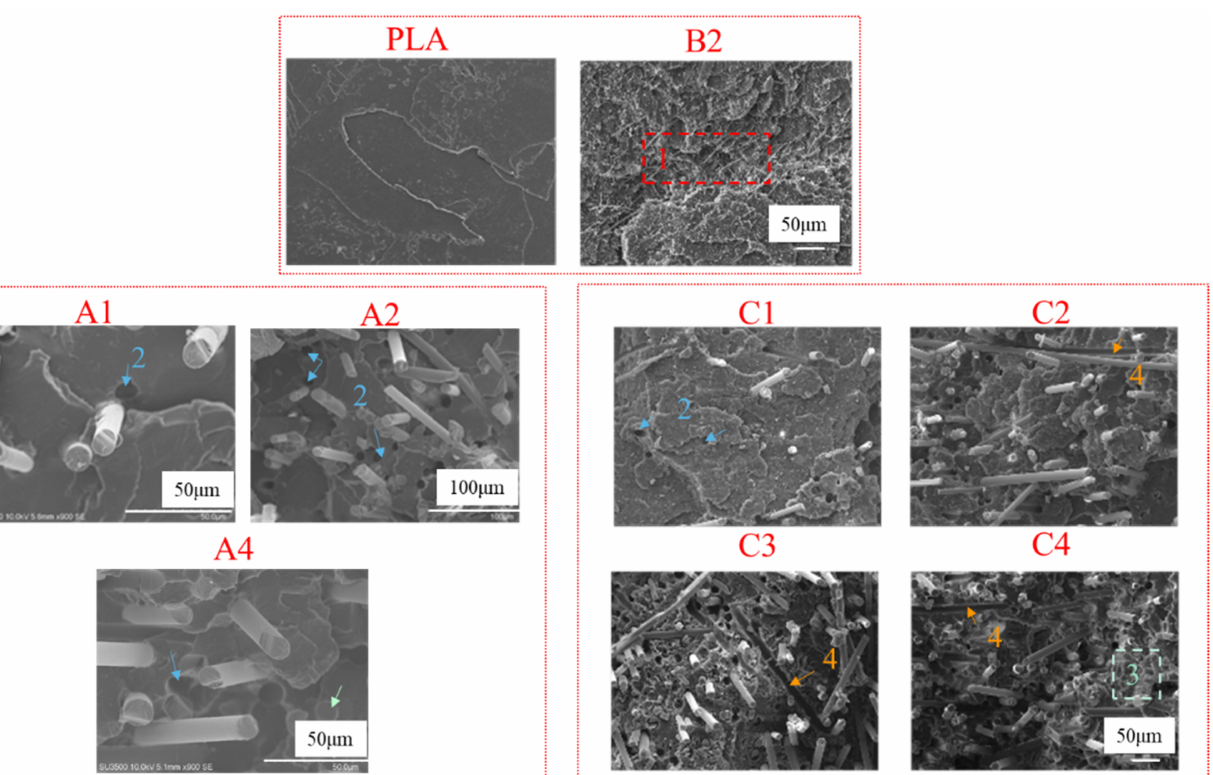
Figure 8. The tensile fracture morphology of PLA, groups A (A1, A2, A4), B2, and group C (C1-C4), where the phenomenon of area 1 was craze, area 2 was fiber pull-out, area 3 was fiber fracture, and area 4 was fiber